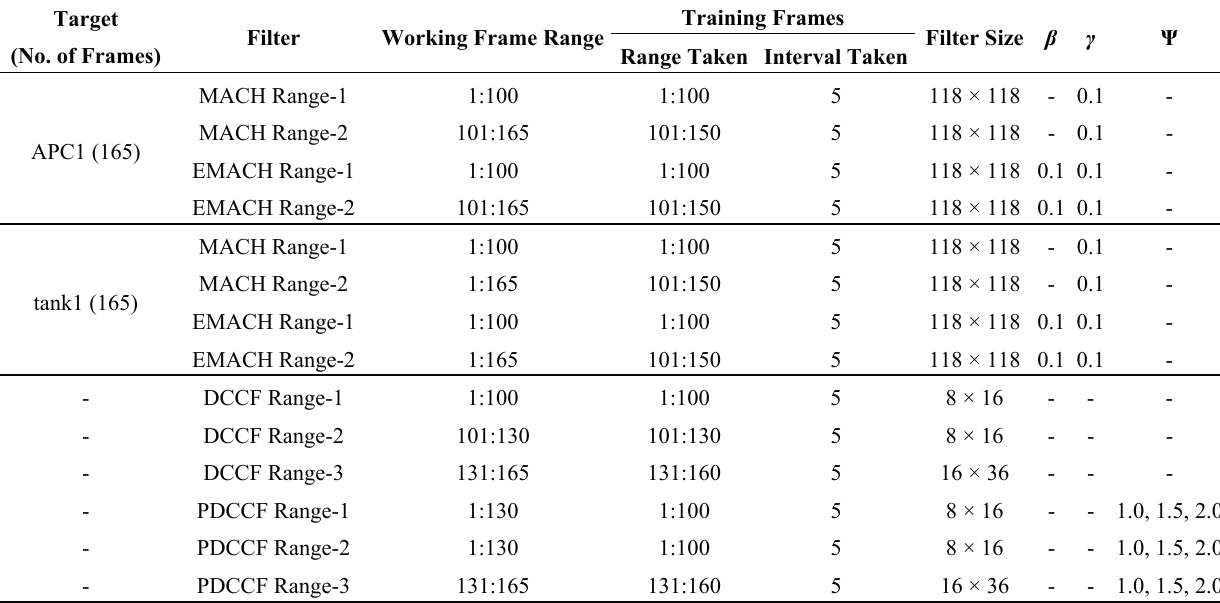
Table 7. Training data for Sequence